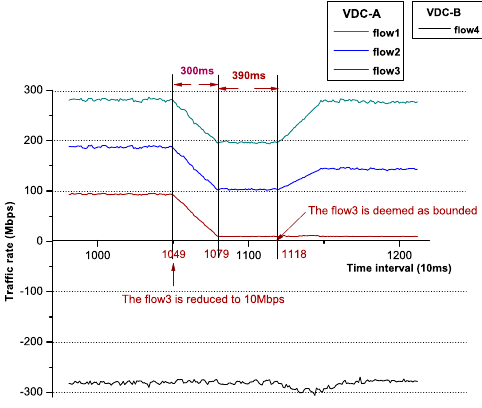
Figure 12. The detailed variation of flow rates in [t0,